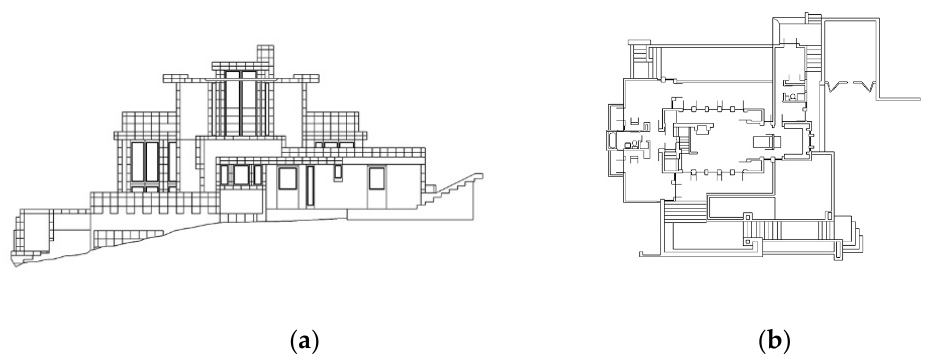
Figure 2. Storer House (1923), a typical example of Wright’s Textile ‐ Block architecture. ( a ) Elevation and ( b ) plan.